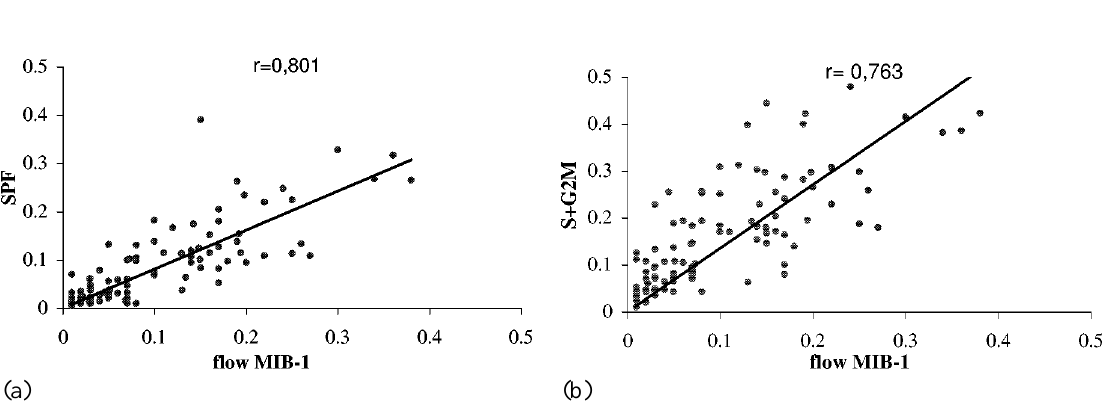
Fig. 9. Linear regression showing the correlation between flow MIB-1 expression and SPF (9a) and S + G2M (9b)